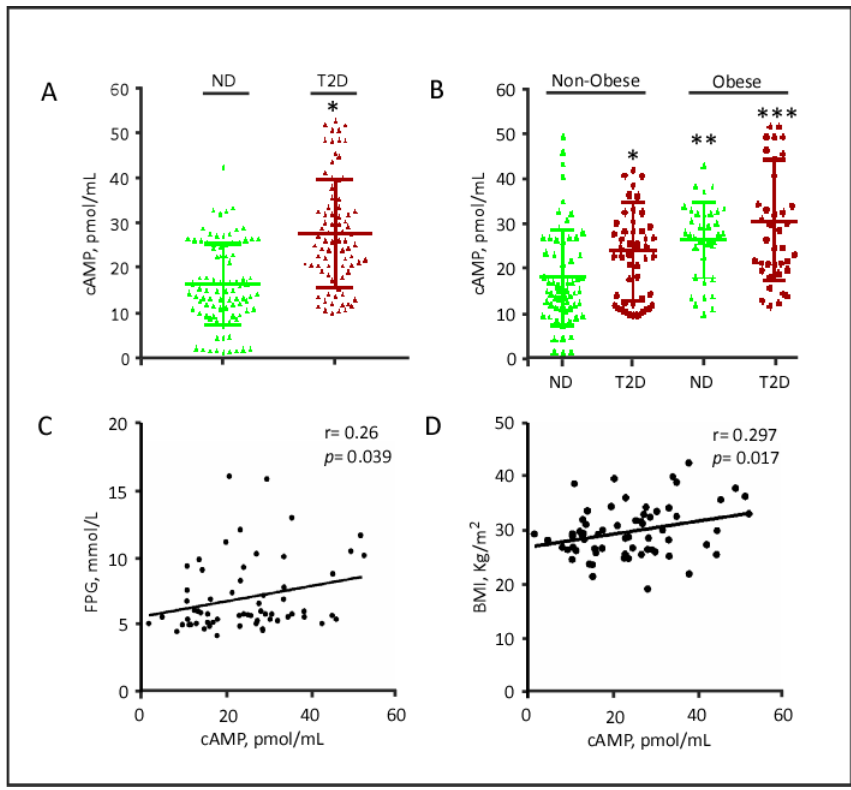
Figure 4. Plasma levels of cAMP in the study population. ( A ) Plasma levels of acetylated cAMP in subjects with and without T2D. ( B ) Plasma levels of acetylated cAMP in obese and non-obese subjects, with and without T2D. Data are presented as mean ± SD. * p < 0.05; ** p < 0.01; *** p < 0.001, as calculated by Student’s t -test, using data from non-obese, non-diabetic (ND) individuals as reference values. ( C